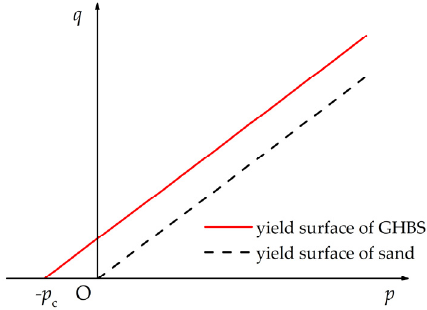
Figure 1. Schematic diagram of the yield surface.